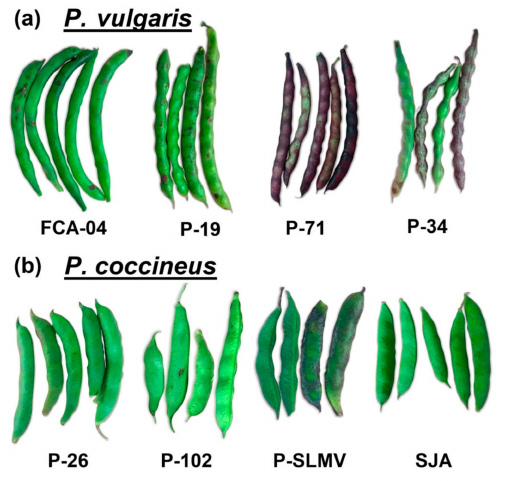
Figure 1. Landrace green bean samples evaluated of P. vulgaris ( a ) and P. coccineus ( b